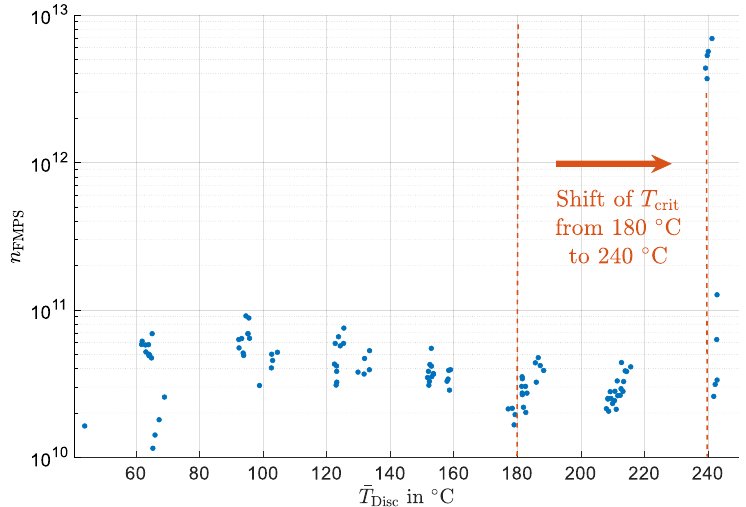
Figure 6. Total number of particles n emitted per brake event plotted versus the average disc temperature during the brake event for pad material with an inorganic binder.